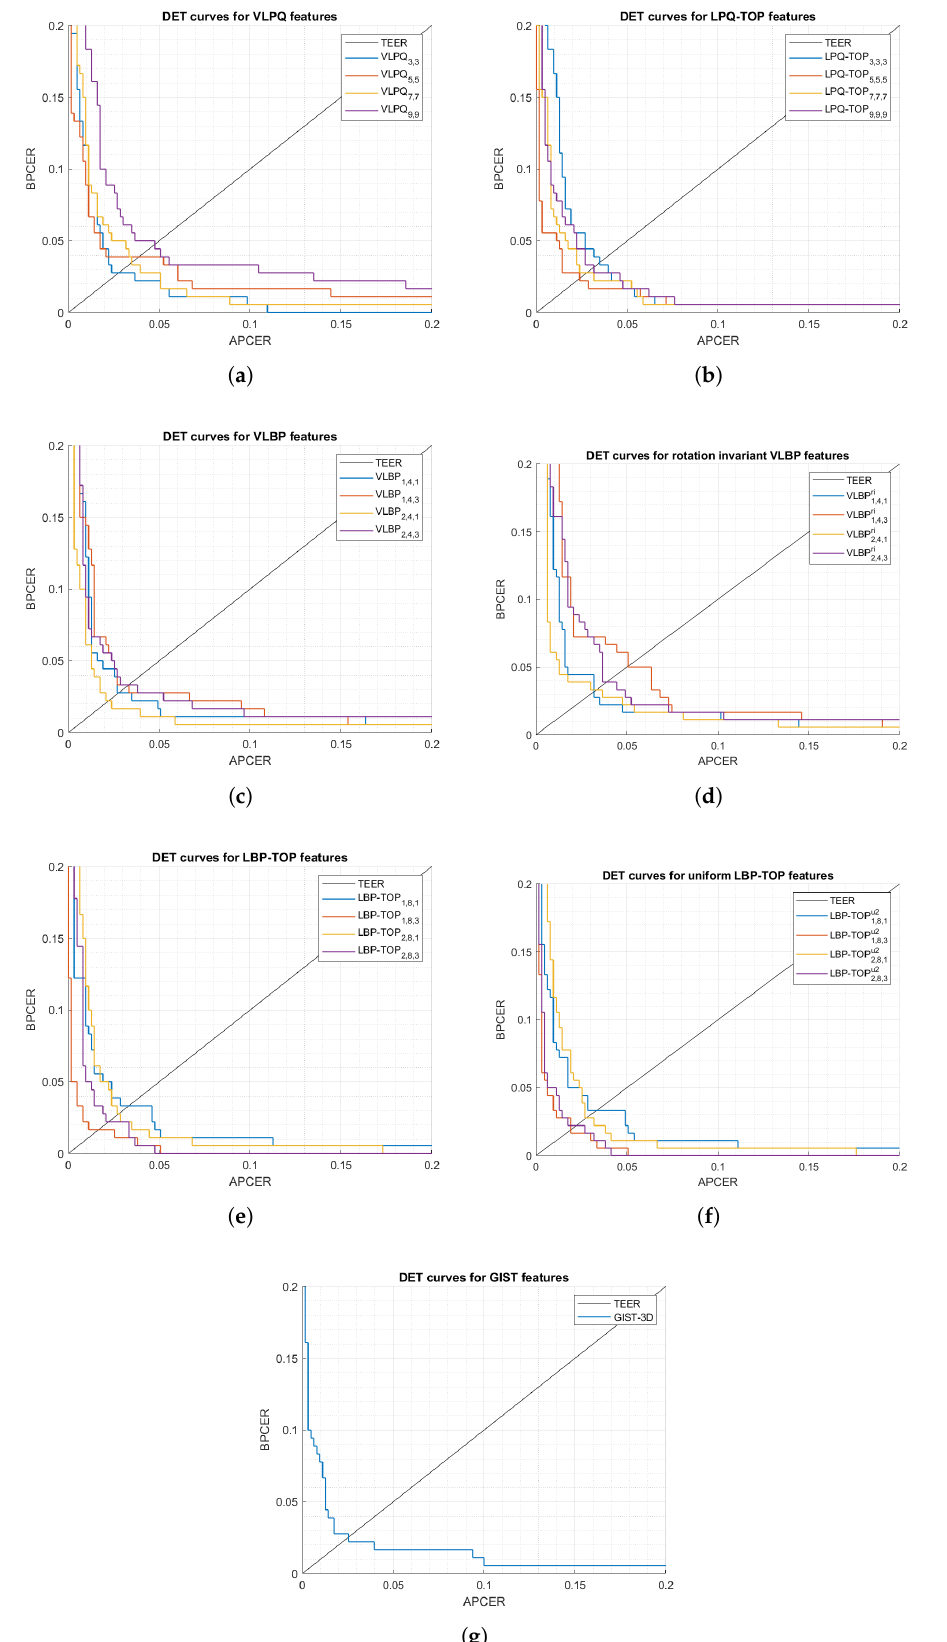
Figure 6. Detection Error Trade-offs (DET) curves for the five feature extractors (optical